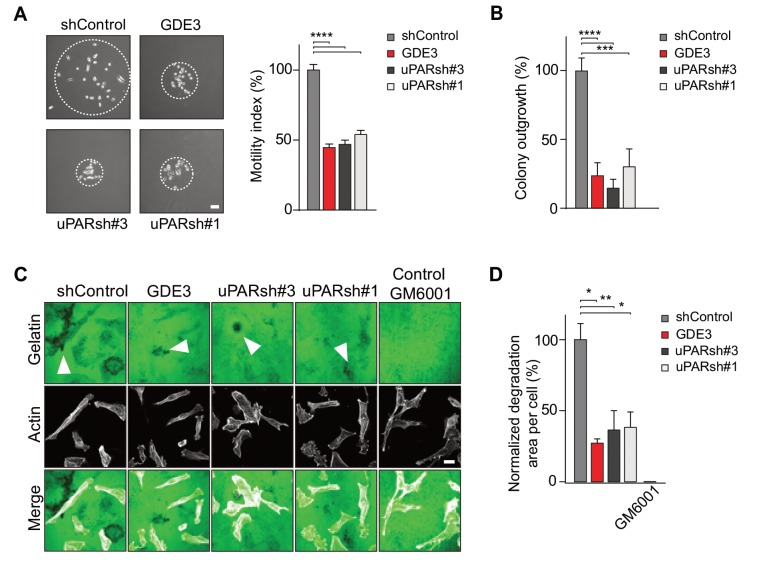
GDE3 attenuates the uPAR-dependent transformed phenotype of breast cancer cells.(A) GDE3 overexpression in MDA-MB-231 cells mimics uPAR knockdown in inhibiting cell scattering. MDA-MB-231 cells grow out as scattered colonies; bar, 100 μm (n = 3, mean ±SEM; ***p<0.001; ****p<0.0001). (B) GDE3 overexpression mimics uPAR knockdown in suppressing colony formation. colonies were counted after 14 days (n = 3, mean ±SEM; ***p<0.001; ****p<0.0001. (C) Degradation of a gelatin matrix mixed with vitronectin by MDA-MB-231 cells in the presence of serum (bar, 10 μm). Arrows point to black spots where gelatin was degraded. Metalloprotease inhibitor GM6001 was used as a control. (D) Quantification of matrix degradation at 20 hr after plating (mean ±SEM; *p<0.05; **p<0.01).